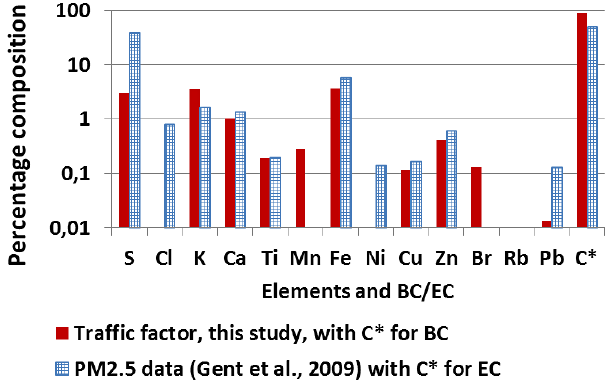
Figure 7. Traffic factor from PMF analysis of PM 2 . 5 from this study compared with PM 2 . 5 from a traffic-polluted site in Connecticut, USA (Gent et al.,